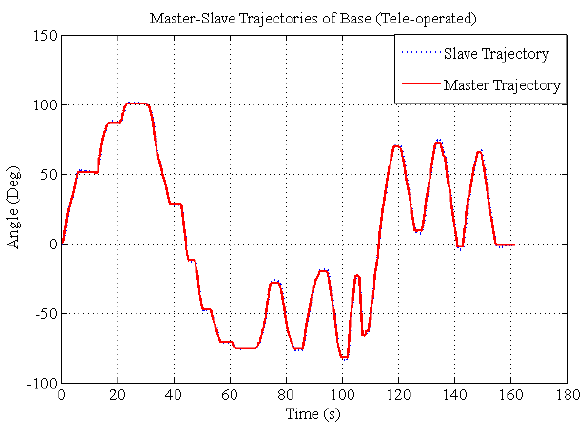
Figure 20. Master / slave trajectories for the base. Figure 20. Master/slave trajectories for the base. Figure 20. Master/slave trajectories for the base.